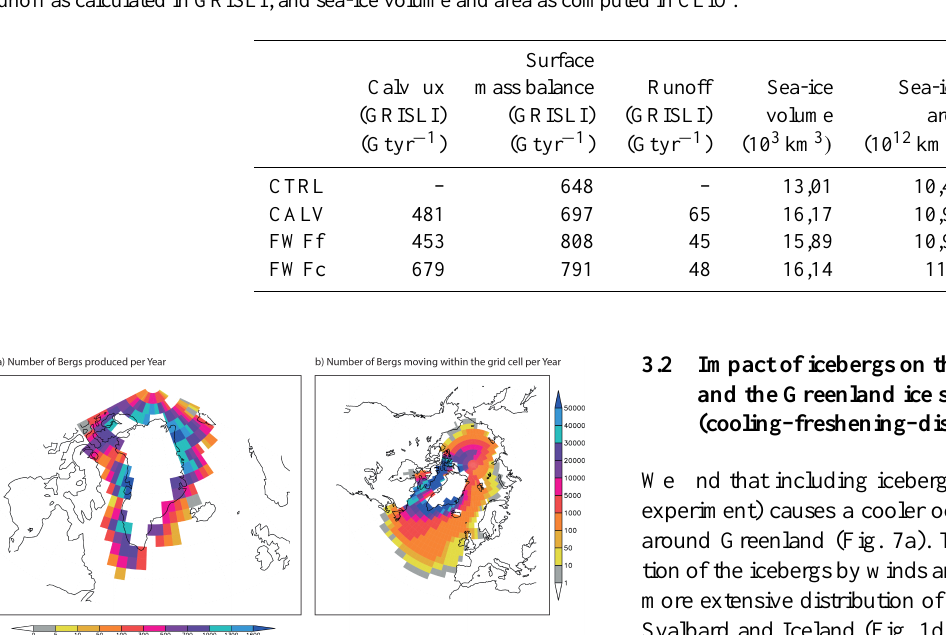
Table 3. Summary of computed ice discharge (Calvflux) as calculated in GRISLI, surface mass balance (SMB) of the Greenland ice sheet, runoff as calculated in GRISLI, and sea-ice volume and area as computed in CLIO.